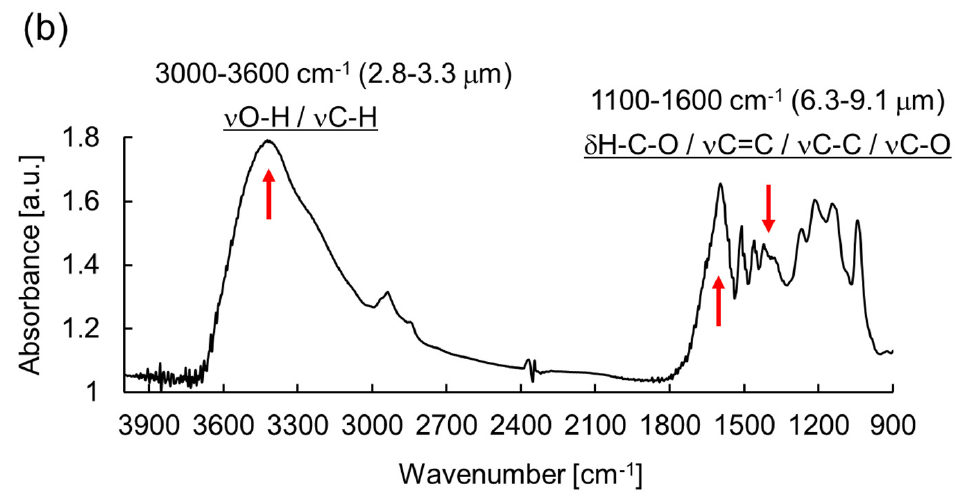
Figure 1. ( a ) Exterior of IR-FEL oscillation system. The instrument is constructed mainly of three devices ( italic ) in a synchrotron radiation facility: electron-linear accelerator, undulator (periodic magnetic field), and resonator mirrors. The laser beam is extracted from a coupling hole (0.4–1.0 mm in diameter) and transported to a laboratory. ( b ) FT-IR spectrum of lignin at mid-infrared (900–2000 cm − 1 ) and near-infrared (2500–3900 cm − 1 ) regions. Each region contains several molecular vibrational modes (underlines). Red arrows indicate absorption bands (3448, 1587, and 1408 cm − 1 ) targeted for IR-FEL irradiation.